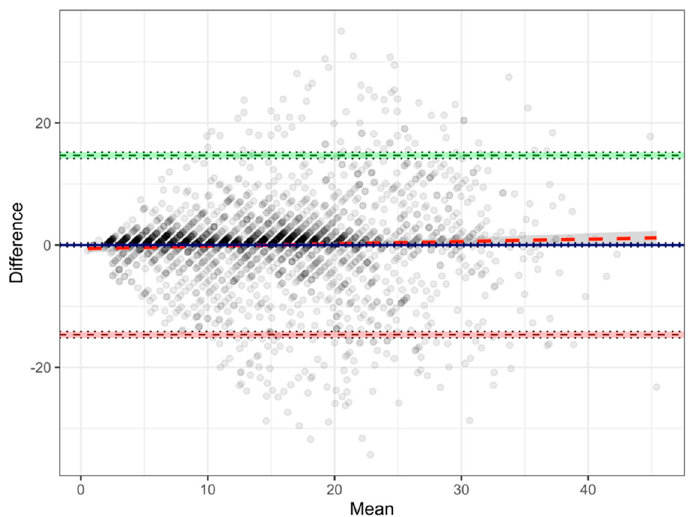
Figure 1. Bland-Altman plot of officially recorded vs. self-reported length of mining service Figure 1. Bland ‐ Altman plot of officially recorded vs. self ‐ reported length of mining service (n = (n = 2379). 2379).